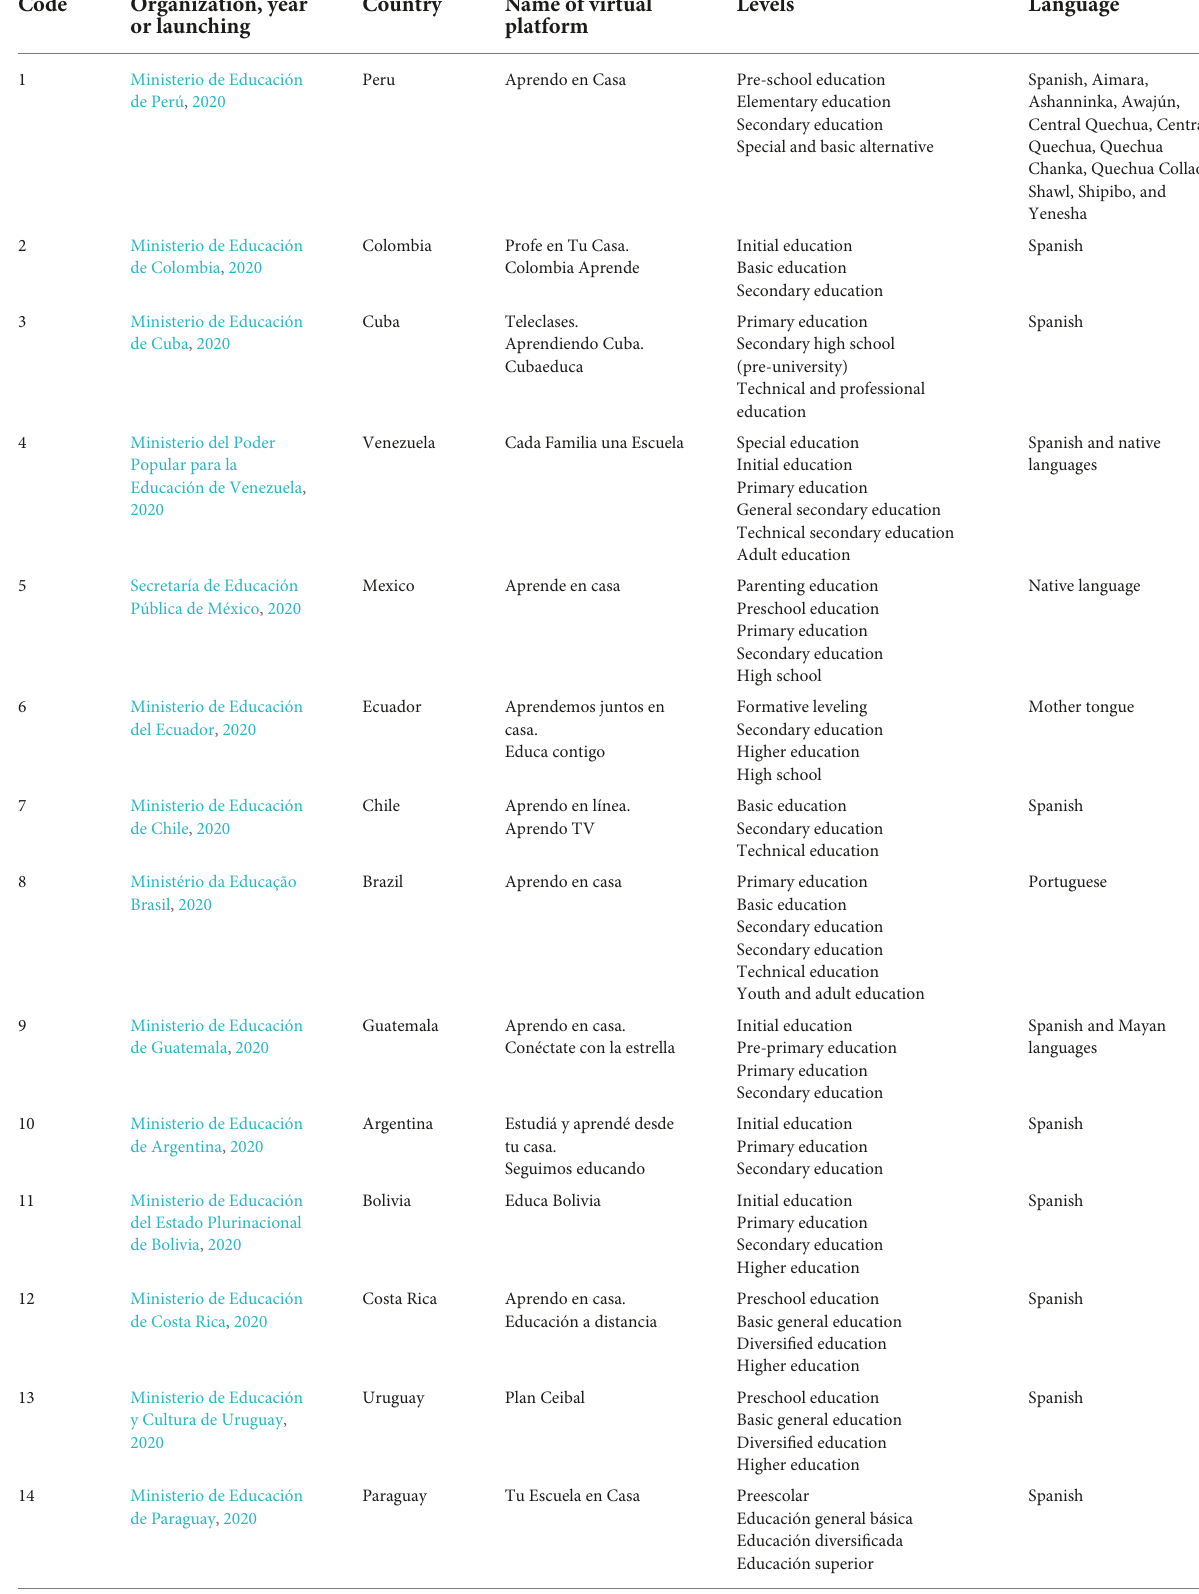
TABLE 1 Name of the programs undertaken by the governments of Latin